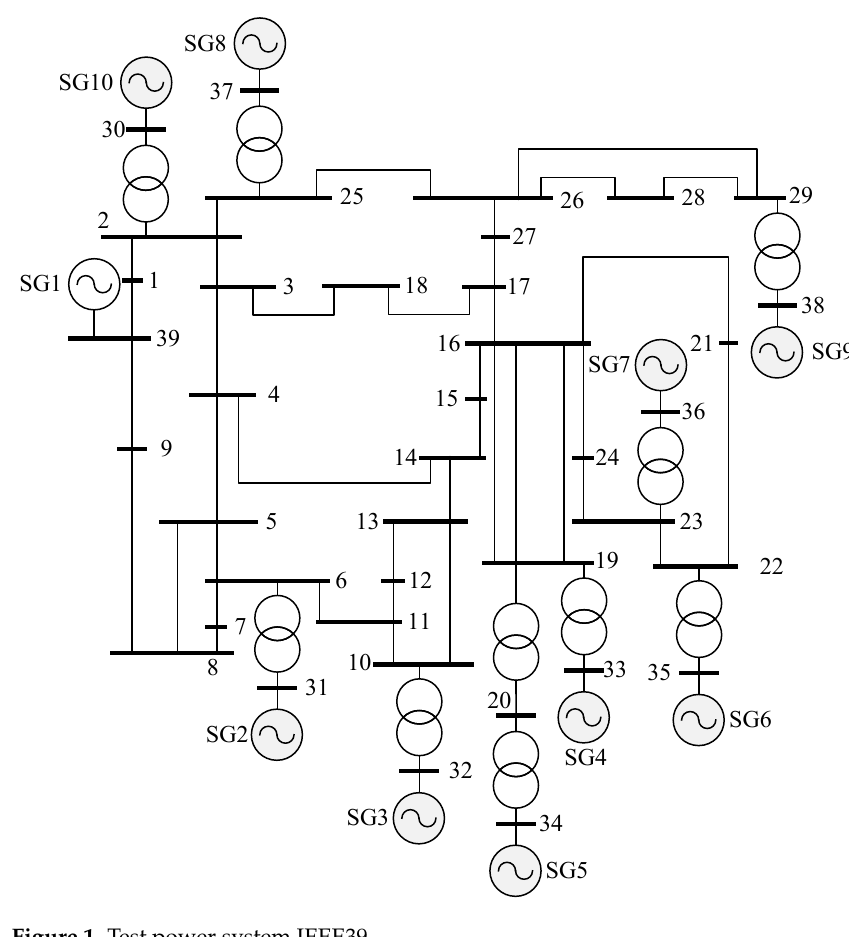
Figure 1. Test power system IEEE39.